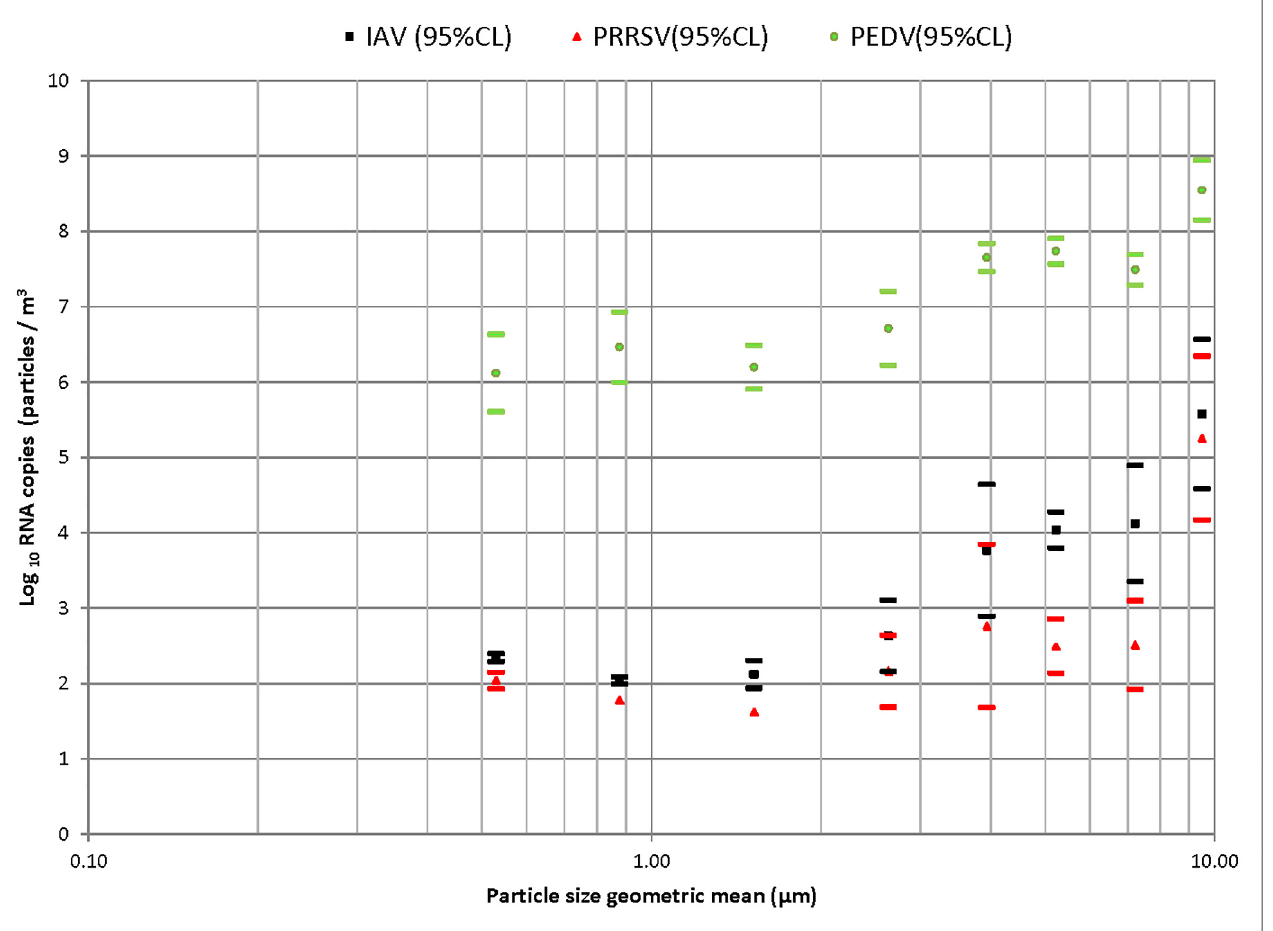
Fig 2. Particle size distribution of airborne viruses. Particle size distribution (Least Squares Means of log10 RNA copies/m3 of air and 95% confident interval) for influenza, porcine reproductive and respiratory syndrome and porcine epidemic diarrhea viruses detected by the Andersen cascade impactor from aerosols generated by infected pigs.